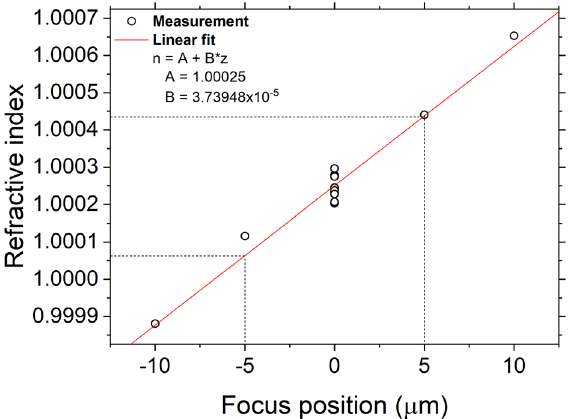
Figure 10. The inferred refractive index of air linearly varies with the focus position. The inaccuracy in the 4 focus position possibly induces ∼ 10 − random error in the sample refractive